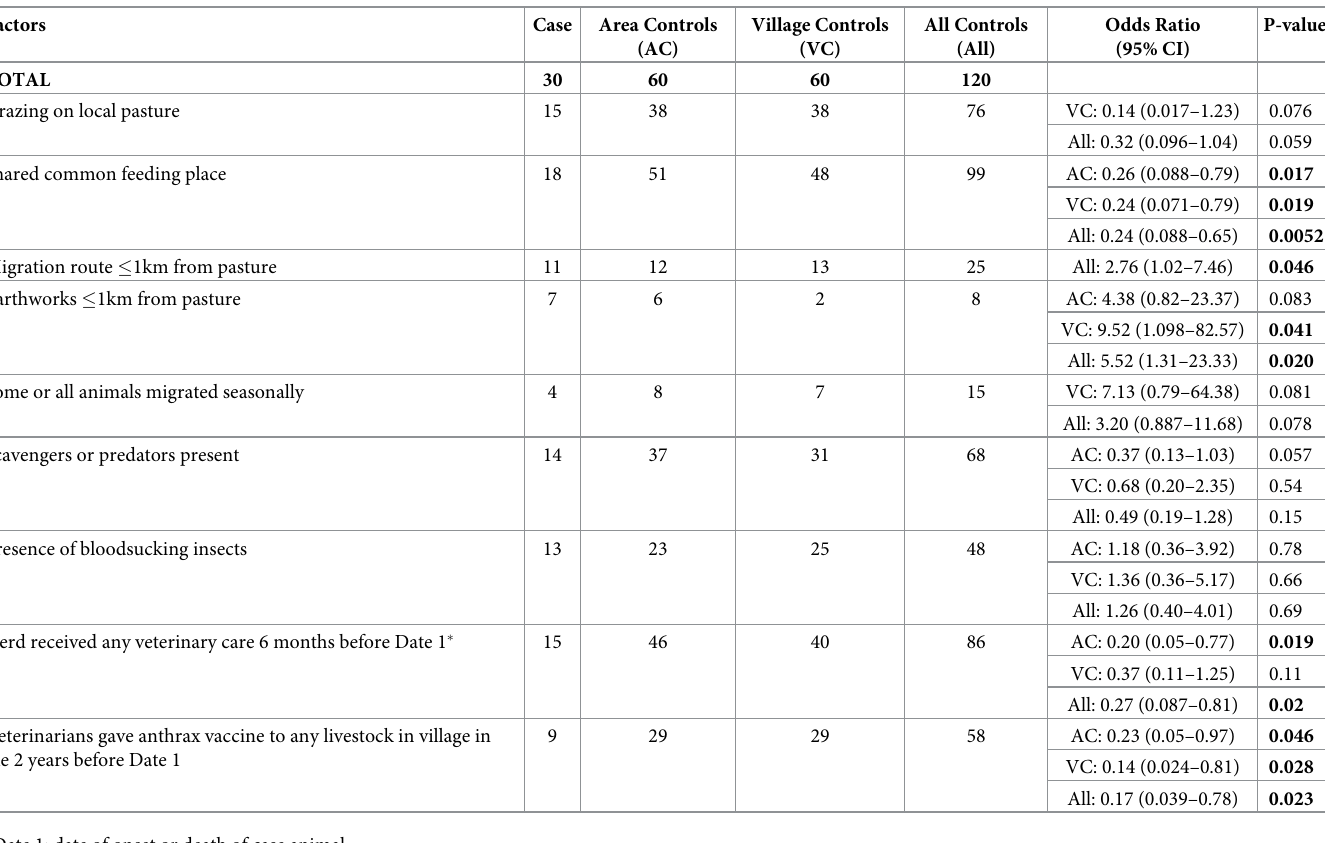
Table 3. Factors associated with anthrax in univariate conditional logistic regression analysis: Cases vs village, area and all controls.